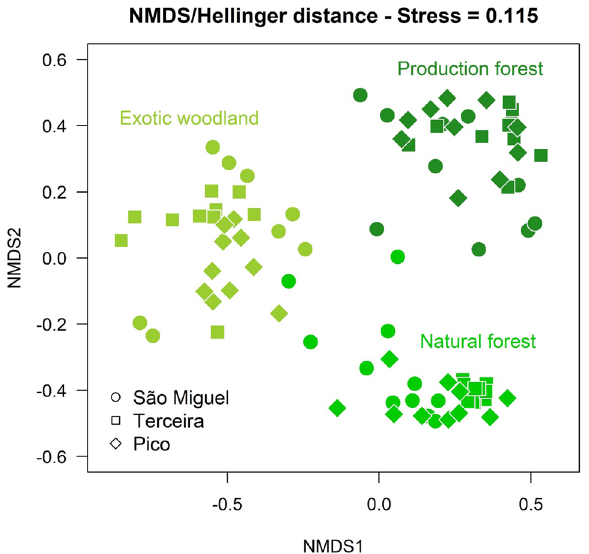
Figure 1. Non-Metric Multidimensional Scaling applied to the Hellinger distance matrix, based on plant species abundances, and applied to all forest types. The three colors represent the three community types obtained by using numerical ecology methods: Natural Forest, Exotic Woodland and Production Forest.